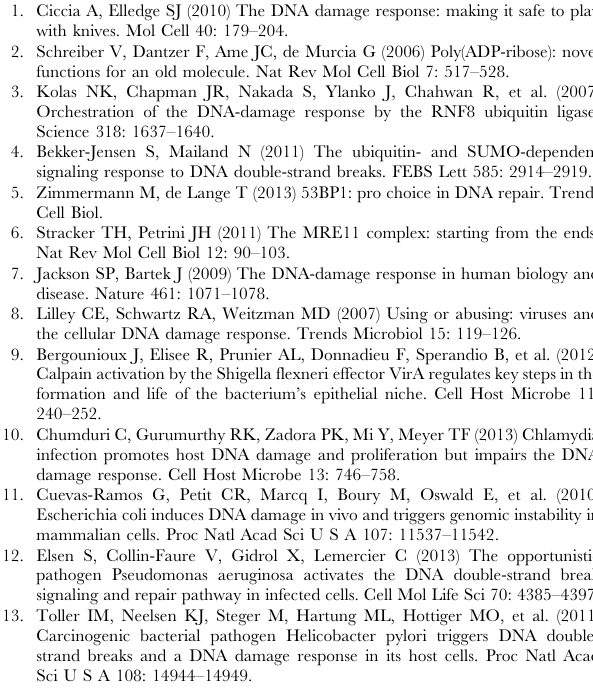
Figure S4 c H2AX and Mre11 levels in JEG3 cells. (A) and (B) JEG3 cells were infected with the indicated strain of Listeria for 24 h. Cell extracts were harvested for immunoblotting. Quanti- fications are normalized to actin and to the uninfected sample. All quantifications in graphs show the mean + / 2 SEM (** p , 0.01). (PDF) Figure S5 c H2AX in vivo. Immunoblot of peritoneal content from C57Bl/6J mice infected with Listeria for 6 hours. n = 6 mice per condition. Quantifications in graphs show the mean + / 2 SEM (* p , 0.05, ** p , 0.01). Recovered colonie forming units for each conditions were as follows: WT, 46 + / 2 29 and D hly, 45 + / 2 19. (PDF) Figure S6 Infection levels in siRNA treated cells. HeLa cells are transfected with siRNA (indicated above each image) and infected with L. monocytogenes for 24 h. Immunofluorescence is performed with anti-InlC antibody (green), which measures the level of infection and phalloidin (red), which stains for actin and shows the cell cytoskeleton as well as bacterial induced actin polymerization.